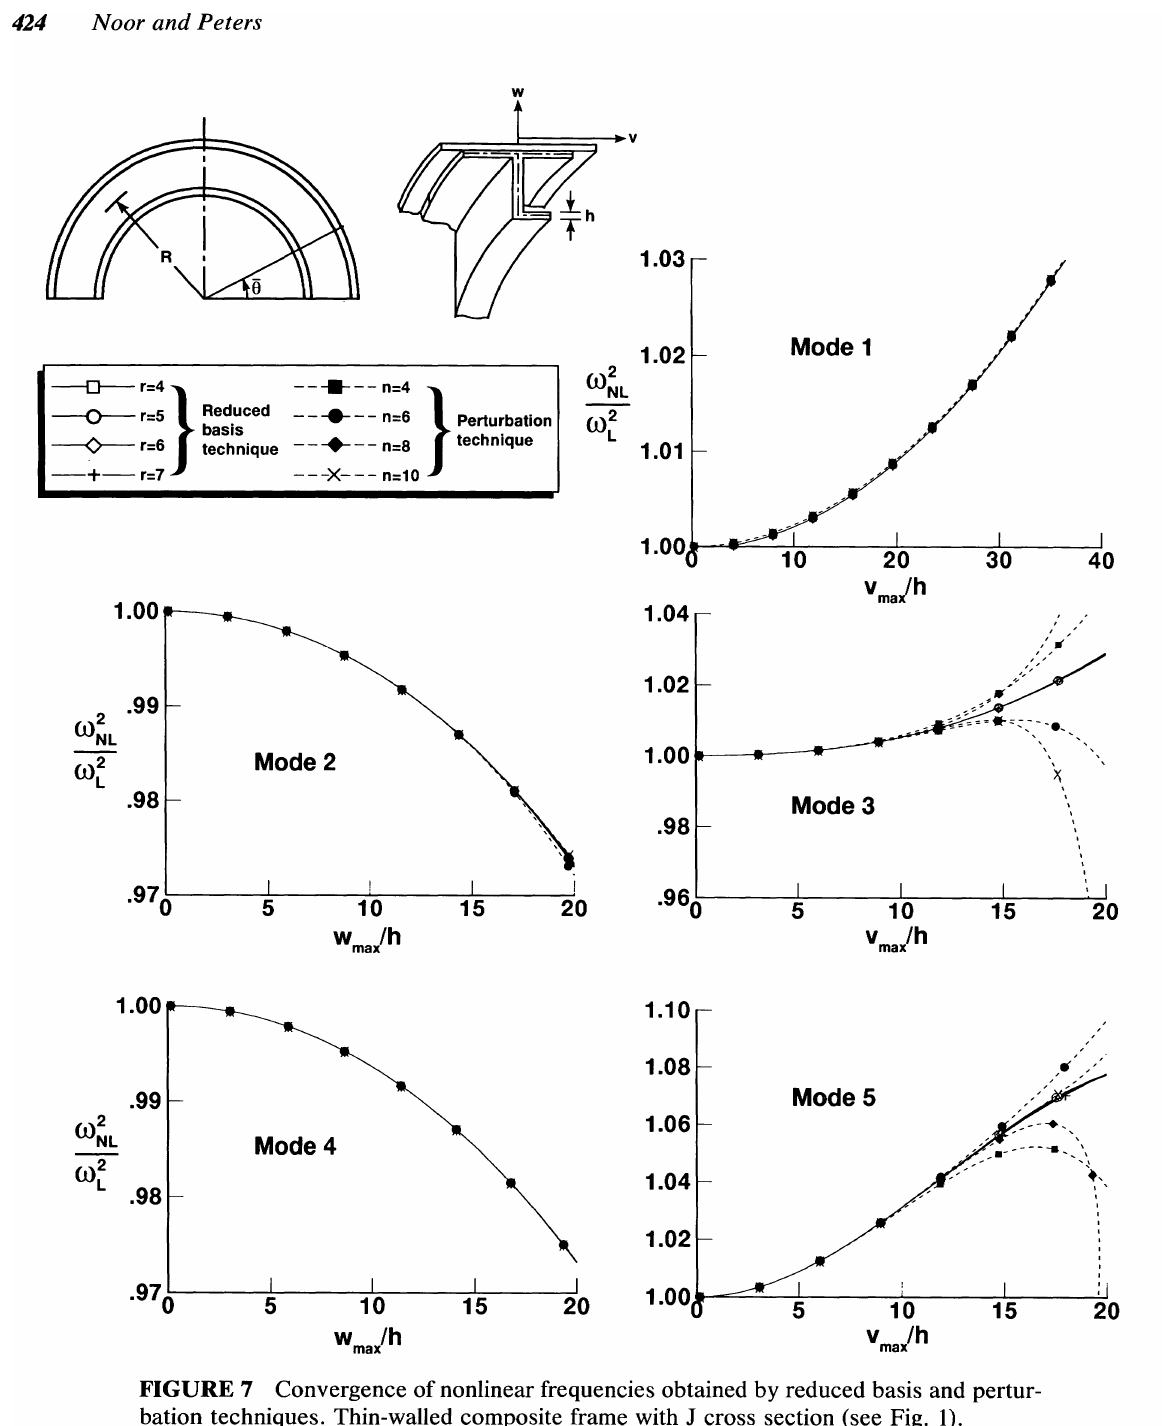
FIGURE 7 Convergence of nonlinear frequencies obtained by reduced basis and pertur bation techniques. Thin-walled composite frame with J cross section (see Fig.